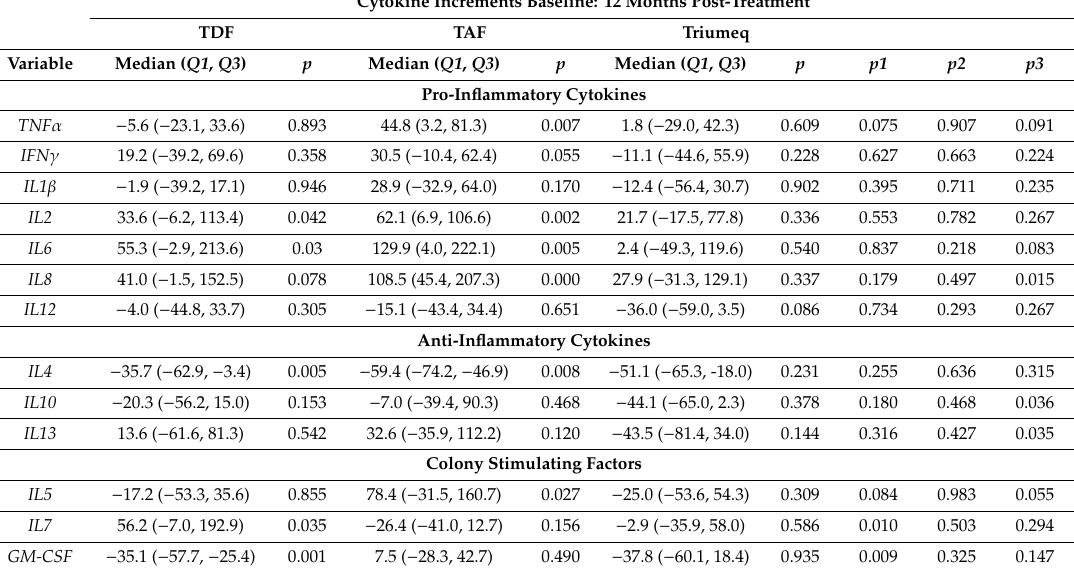
Table 2. Cytokine increments at 12 months after treatment compare to baseline. Median values (interquartil range) and significance ( p ) vs. baseline are shown. p1 : TDF vs. TAF, p2 : TDF vs.